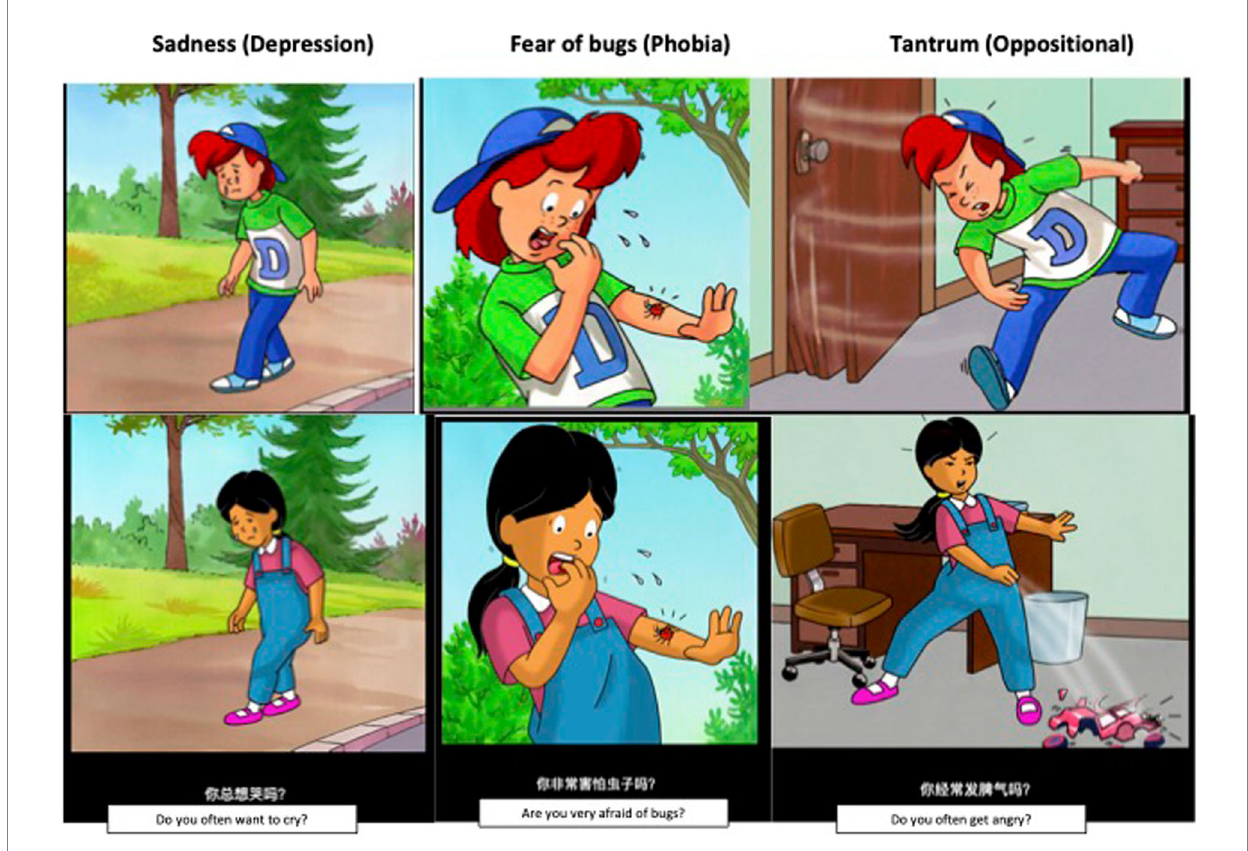
FIGURE 1 Examples of Dominic Interactive slides presented to Caucasian boys (top row) and Asian girls (bottom